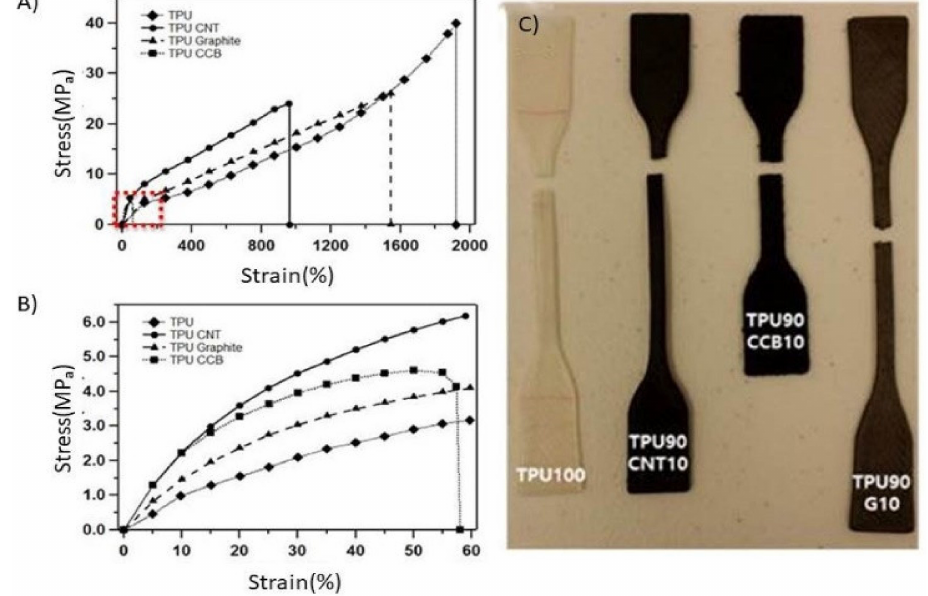
Figure 6. Tensile properties of 3D-printed TPU / C composites objects. ( A ) Stress-strain curve, ( B ) expanded region of stress-strain Curve, and ( C ) specimens fractured under tensile load. The concentration of carbon fillers in all samples in this figure is 10 wt